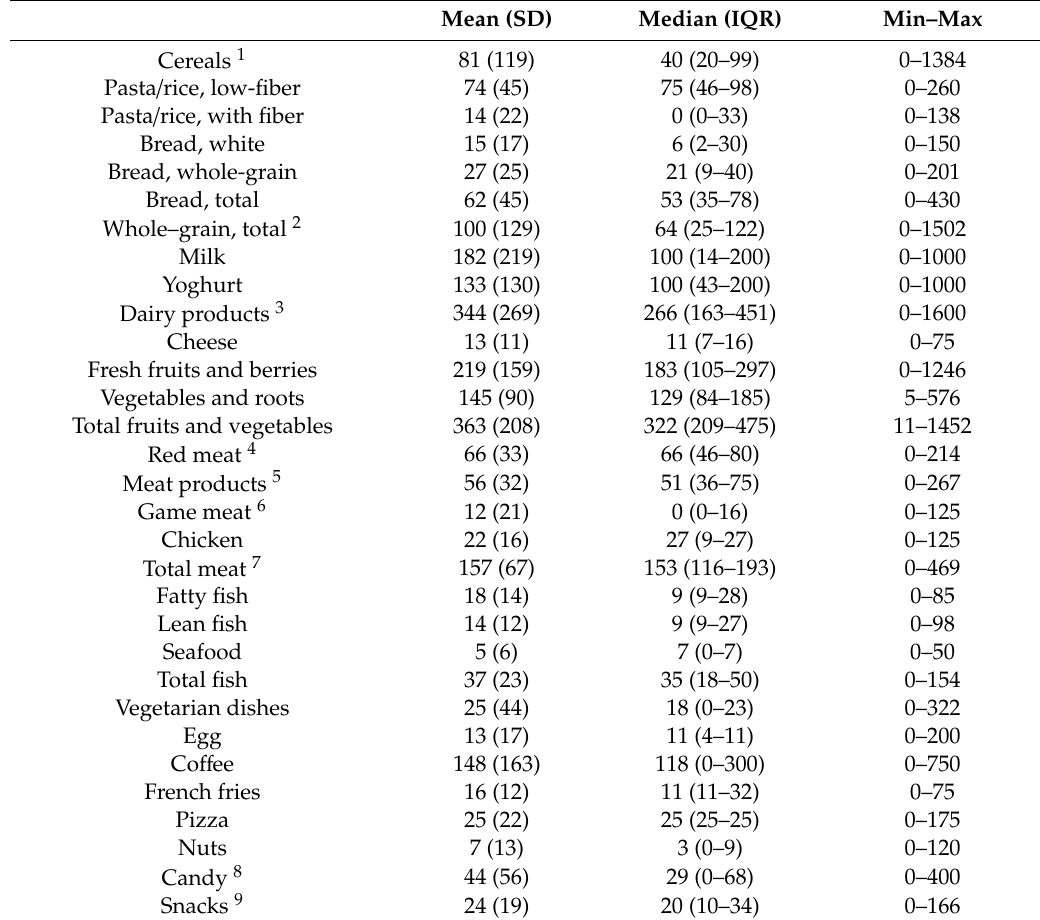
Table 2. Dietary intake of food items, in grams per day ( N =